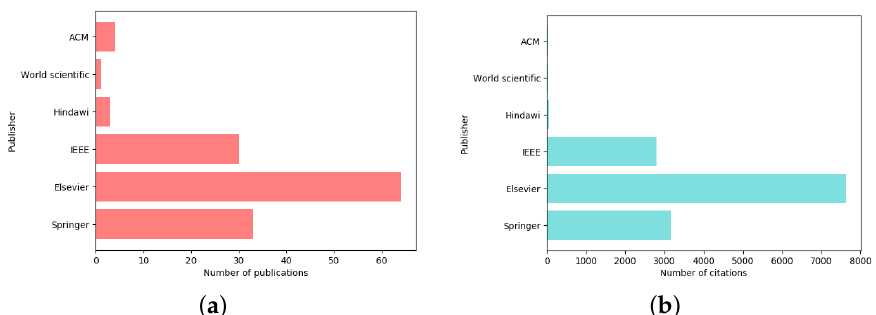
Figure 2. Statistics of the number of publications and citations for papers on NIAs modifications for FS. ( a ) Statistics of publications on modified NIAs-FS; ( b ) Statistics of citations for papers about modified